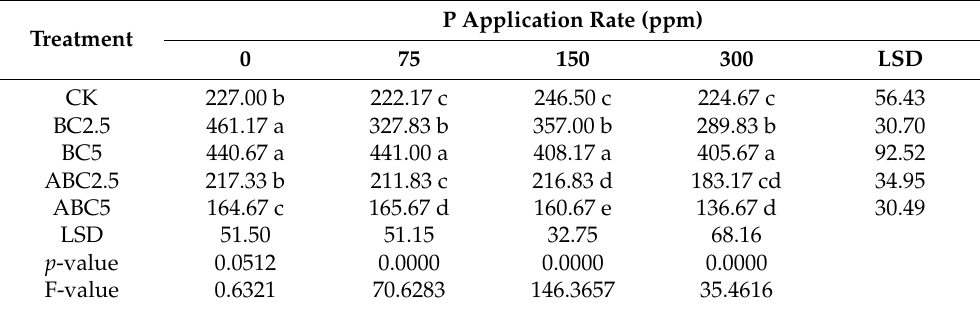
Table 5. Effects of BC and ABC applied at different rates with different P fertilizer application rates on soil extractable Na in